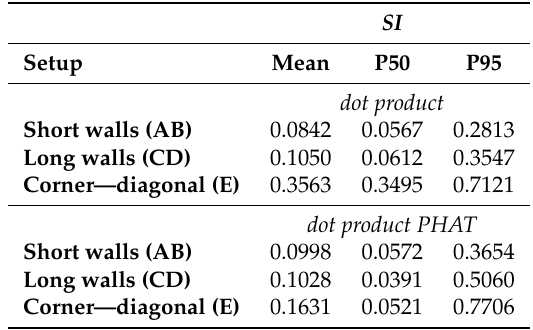
Table 3. SI assessment of the different individual arrays for the two calculation methods using WN recordings.